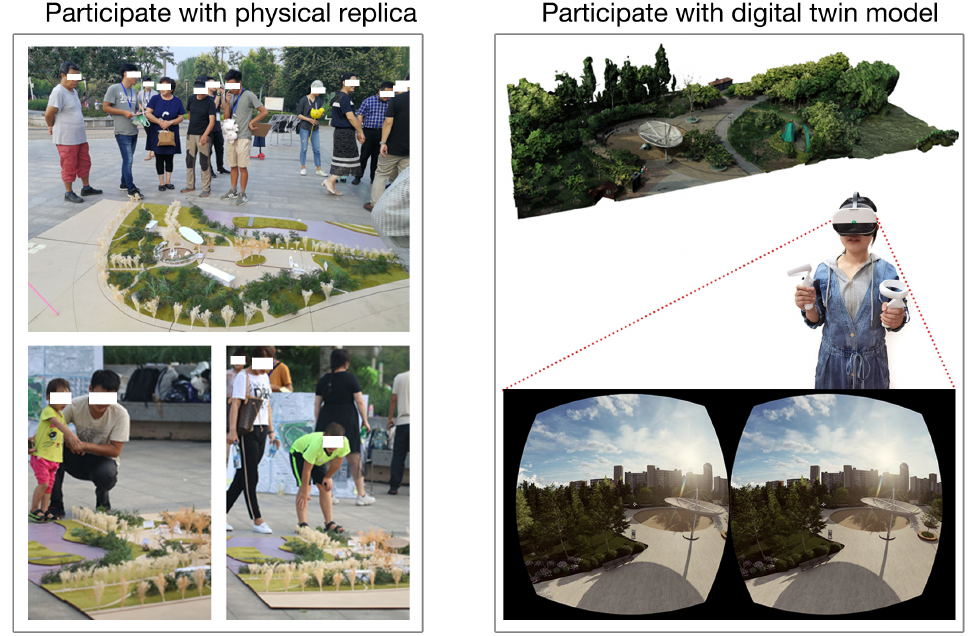
Figure 3. Two groups of participants. One group was involved with a digital twin model, and the other used a physical